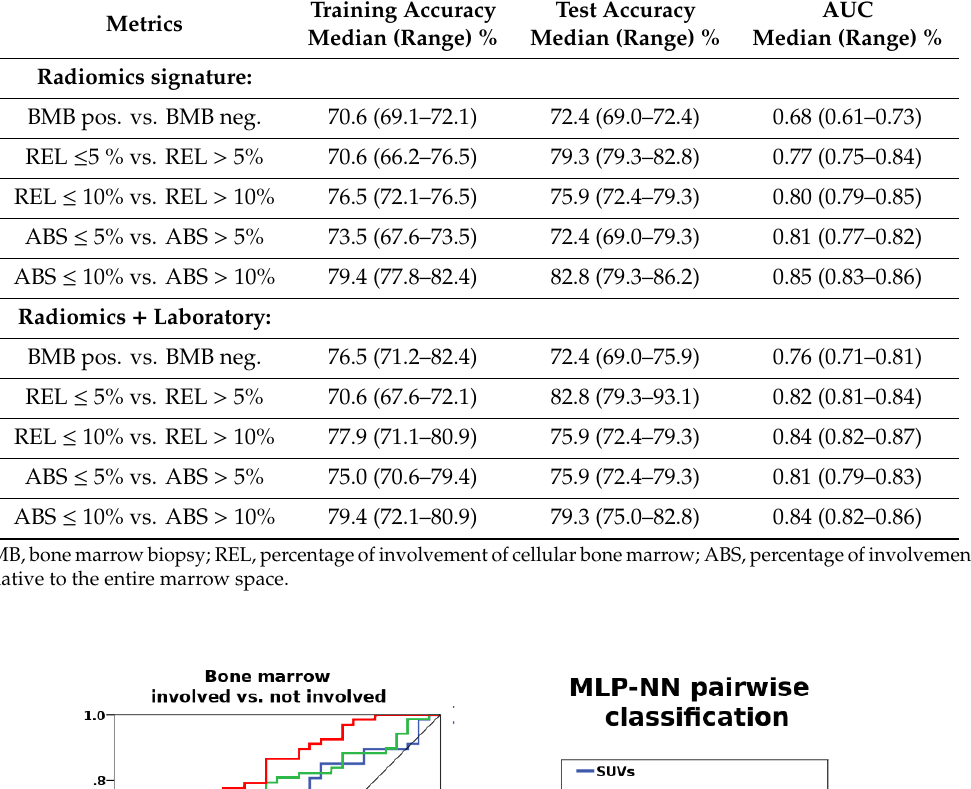
Figure 1. Areas under the receiver operating characteristic curve for standardized uptake values (SUVs) alone; the radiomic signature (SUVs and gray-level co-occurrence matrix (GLCM) features); the radiomic signature combined with laboratory data (WBC and LDH); for assessment of bone marrow involvement. Performance generally improves with the percentage of relative or absolute bone marrow involvement (REL and ABS), but more prominently for the radiomic signature, with and without combination with laboratory data.